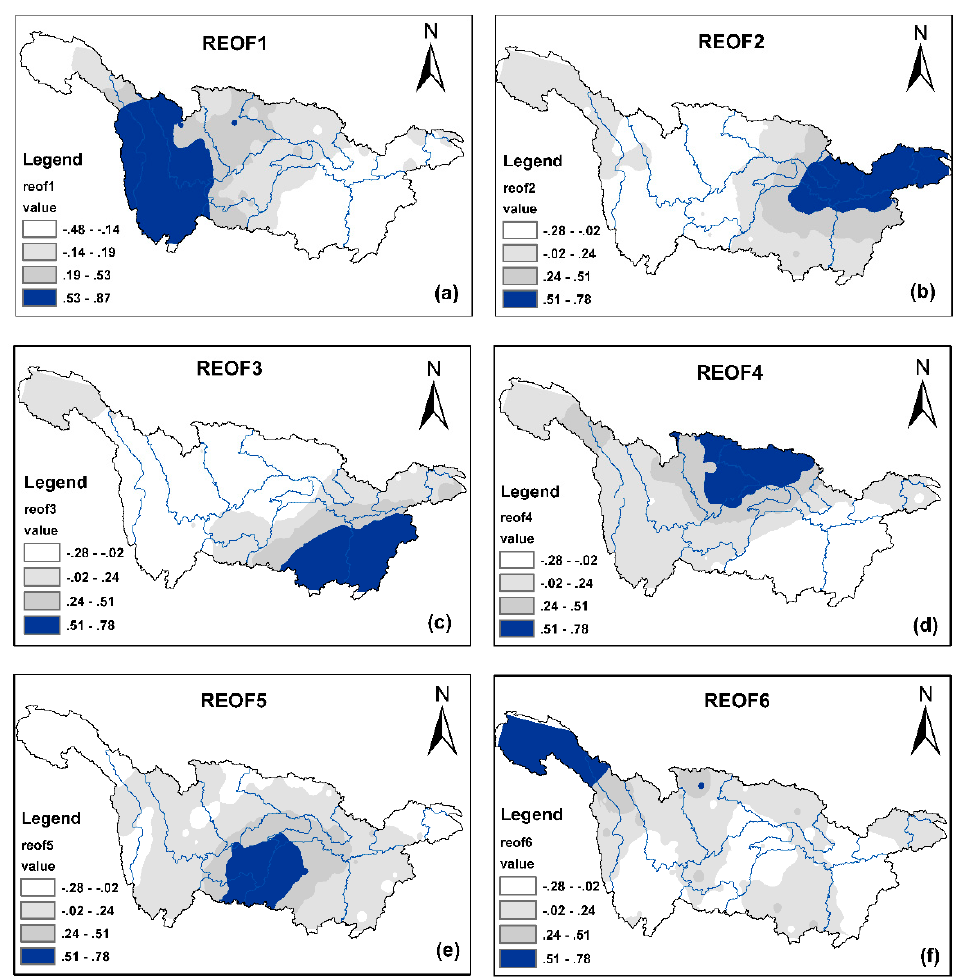
Figure 2. The Rotation Empirical Orthogonal Function (REOF) results of the Standard Precipitation Evapotranspiration Index (SPEI) (at 3-month scale). Mode 1 ( a ), Mode 2 ( b ), Mode 3 ( c ), Mode 4 ( d ), Mode 5 ( e ) and Mode 6 ( f ) are the first six modes. The blue area represents the high loading value. The value of the load is divided into four classes. In order to highlight the difference, the rest of the three lower values are expressed in